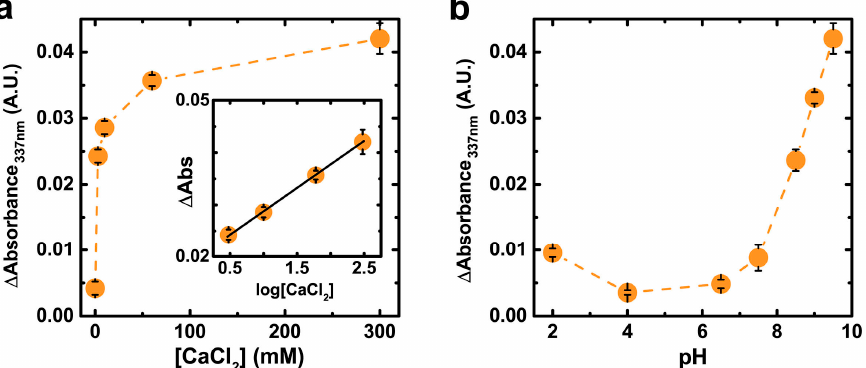
Figure 2. ( a ) Subtracted spectra absorbance at λ Abs = 337 nm after 1 h as a function of [CaCl 2 ] in 50 mM Tris buffer pH = 9.5; ( b ) Subtracted spectra absorbance after 1 h as a function of pH in 300 mM CaCl 2 , 50 mM Tris buffer. See Figure S5 for equivalent data at λ Abs = 487 nm. Data are represented as the average ± SD ( n = 2).